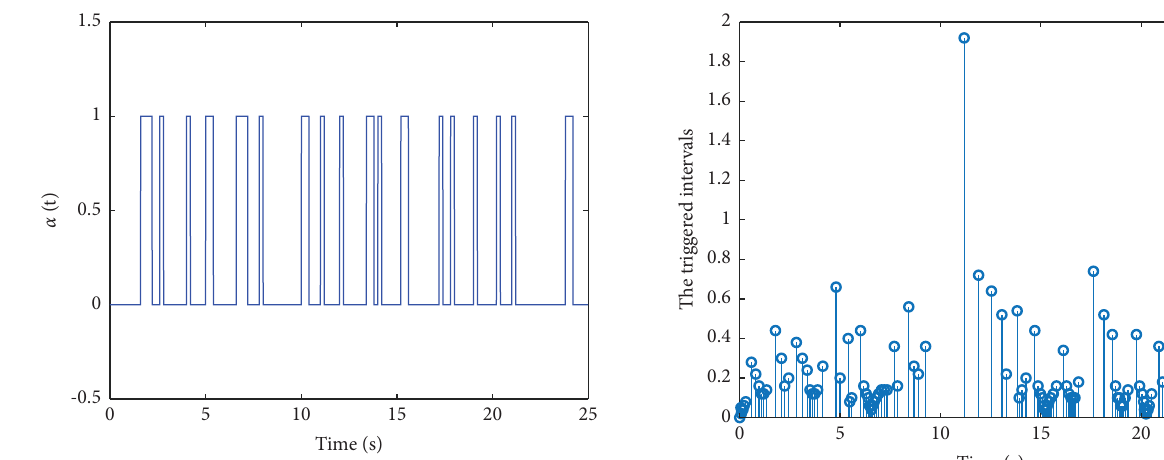
Figure 4: α ( t ) of deception attacks with α � 0 . 2.